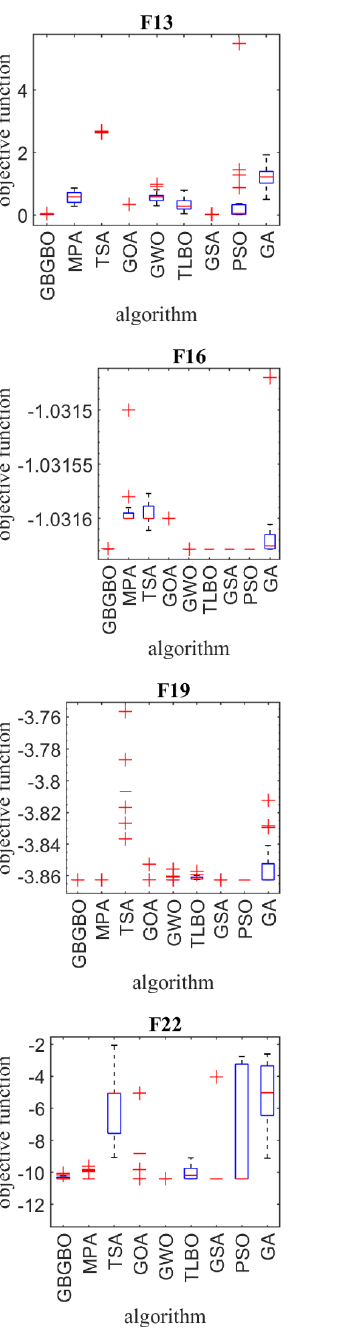
Figure 2. The boxplot of the results of the composition of objective functions for different optimization algorithms.